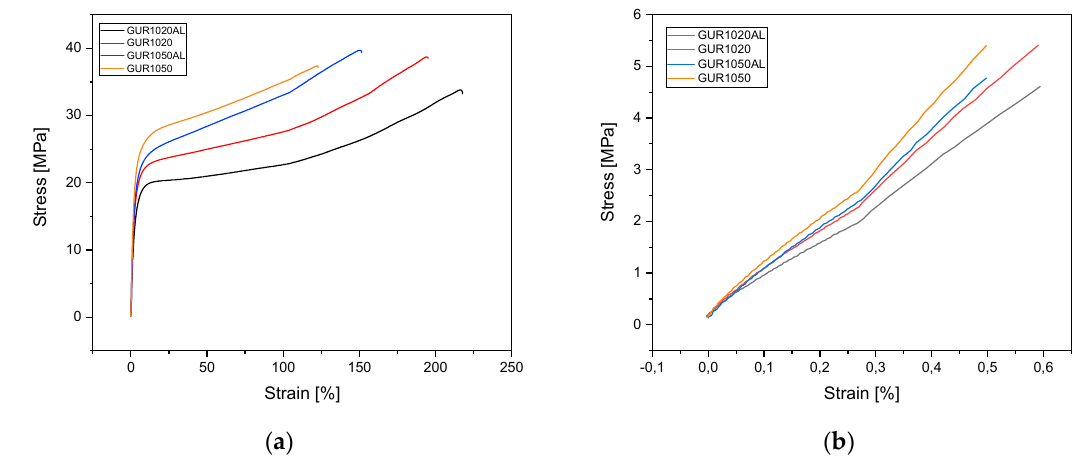
Figure 4. Stress–strain curves ( a ) GUR specimens; ( b ) the initial differences are magnified to facilitate comprehension. Table 4. Tensile test results (N = 6).